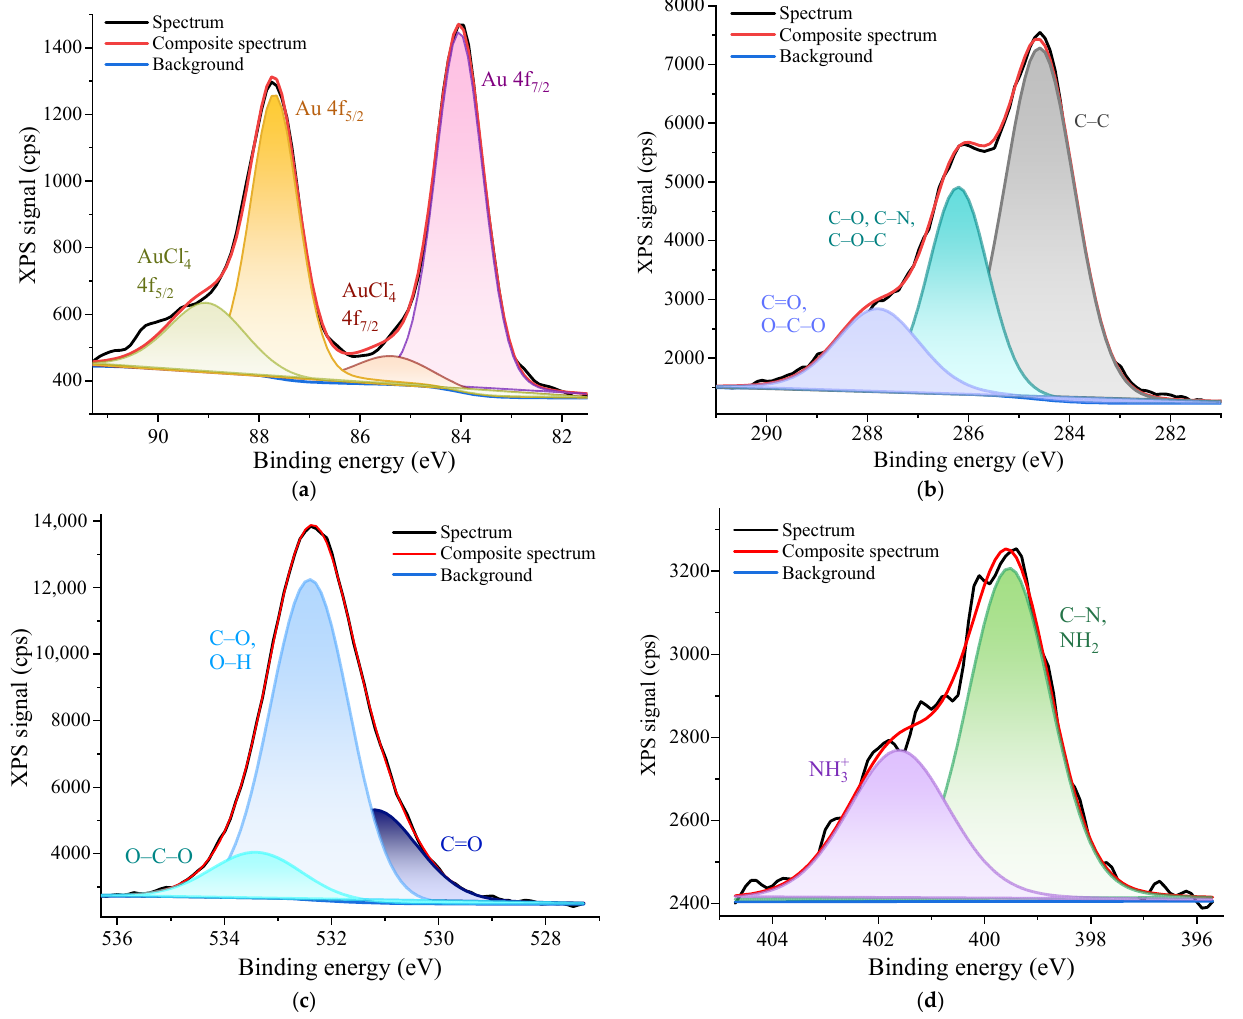
Figure 3. High-resolution deconvoluted XPS spectra of the P 0.12 sample for: ( a ) the Au 4f narrow scan peak; ( b ) the C 1s narrow scan peak; ( c ) the O 1s narrow scan peak; ( d ) the N 1s narrow scan peak.